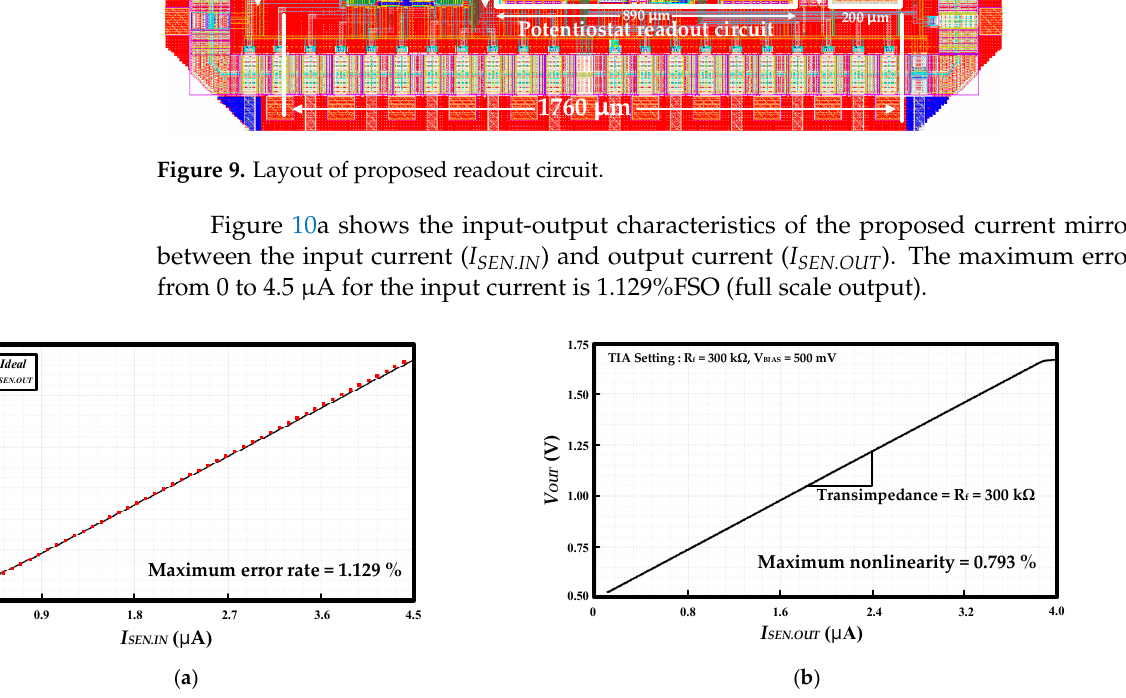
Figure 10. ( a ) Linearity simulation result of the sensing current; ( b ) linearity simulation result of the TIA.